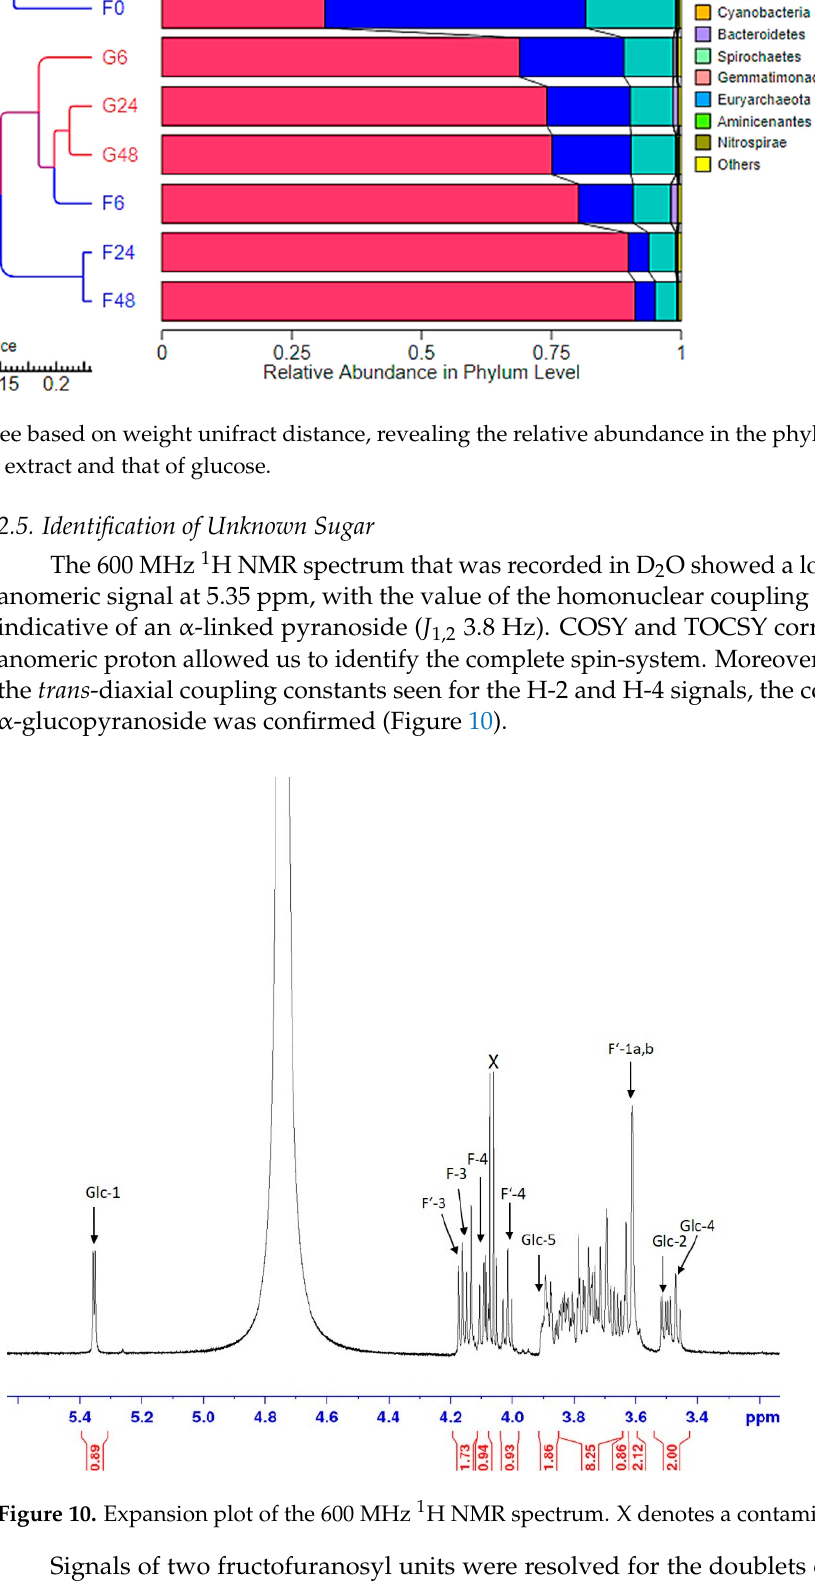
Figure 8. Krona graphs based on relative abundance of bacterial order obtained from the fermentation of glucose (G0, G24, G48) and that of inulin-FOSs extract (F0, F24, F48) at 0, 24 and 48 h of the fermentation processes.